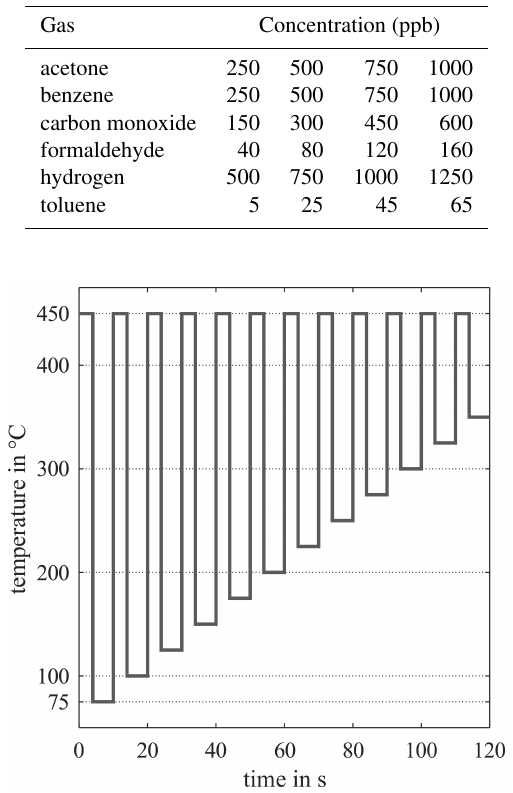
Figure 2. Temperature cycle of the AS-MLV and